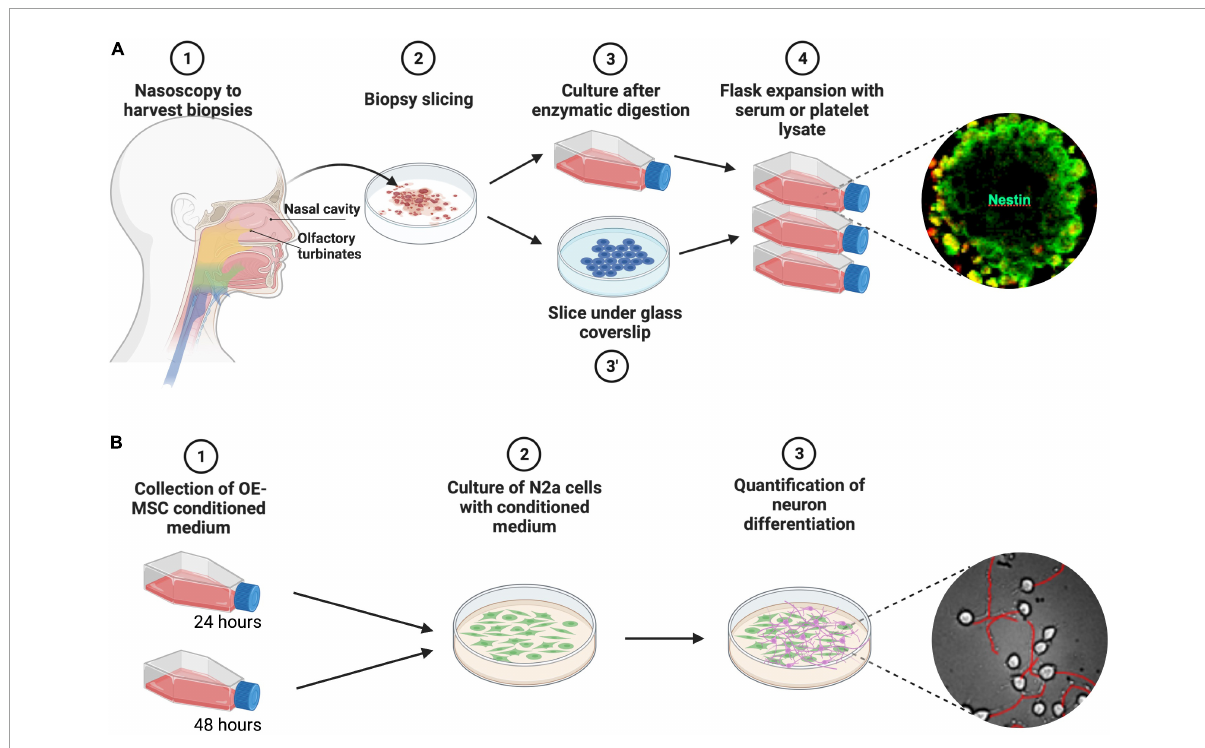
FIGURE1 Schematic description of the two main procedures performed during the study. (A) Purification of olfactory stem cells. After collection, biopsies were chopped and slices were either cultivated under glass coverslips or enzymatically dissociated. Cells were then expanded with fetal calf serum or platelet lysate and characterized. (B) Effect of OE-MSC conditioned medium on neuron differentiation. OE-MSCs were cultivated for 24 h or 48 h and the conditioned medium was collected before being added (50/50) to the culture medium of N2a cells. To assess neuronal differentiation, the number of differentiated cells was quantified at Day 1 and Day